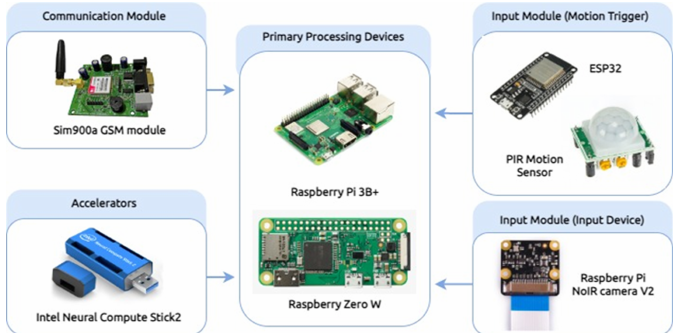
Figure 2. Hardware stack of the proposed